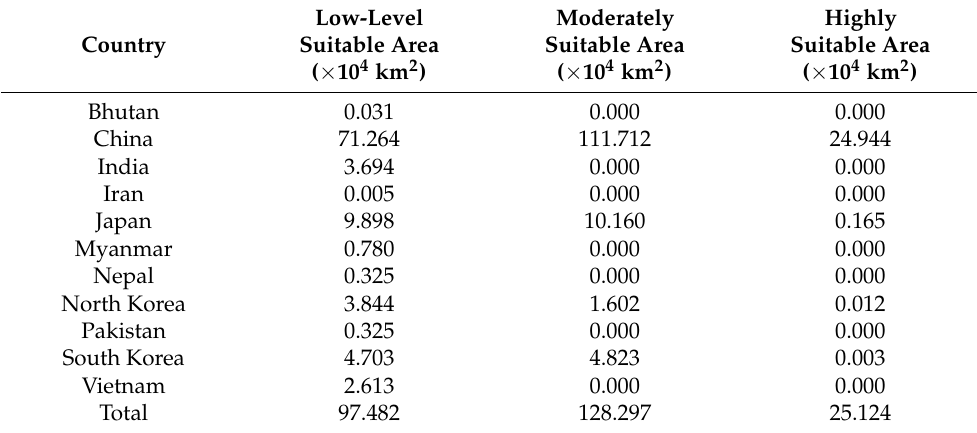
Figure 1 . Population distribution of Liriodendron chinense under current scenario . Figure 1. Population distribution of Liriodendron chinense under current scenario. Table 2. Current distribution area of Liriodendron chinense